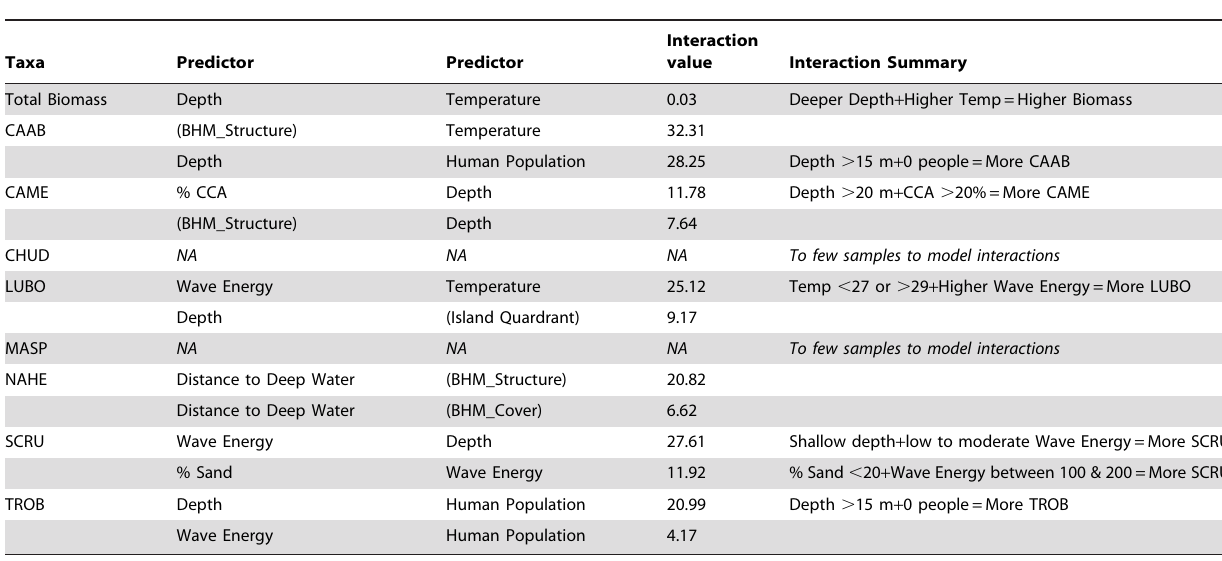
Table 5. Pairwise interactions between predictor variables used to relate total biomass and occurrence of each taxa to environment.